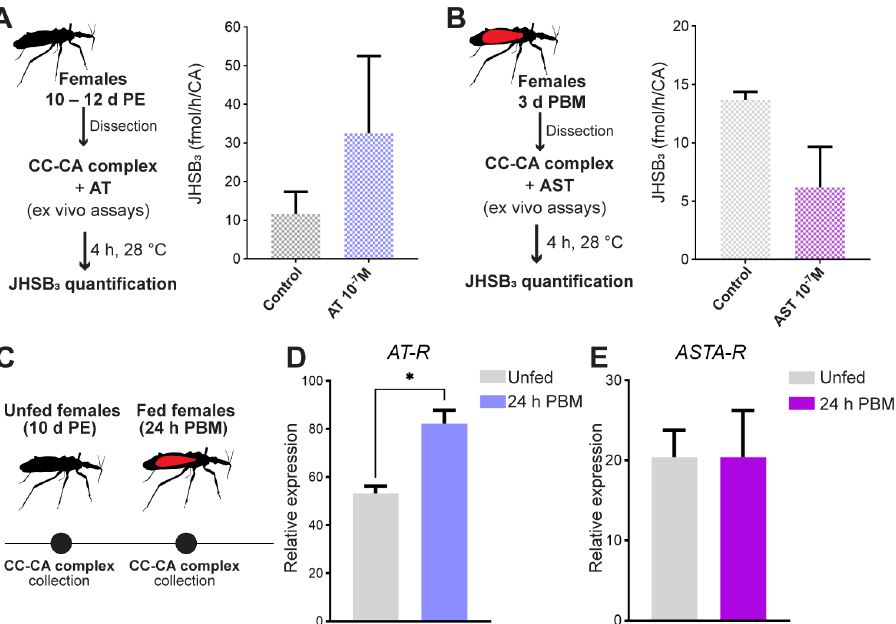
Figure 6. Effect of AT and AST on JHSB 3 synthesis in ex vivo assays. ( A ) CA-CC complexes from unfed females (10–12 d PE), were incubated ex vivo at 28 °C in the dark, for 4 h, in culture medium supplemented with AT (final concentration: 10 − 7 M) or the same volume of saline (control). The y axes represent JHSB 3 levels with respect to control (saline, gray column). The y axis represents JHSB